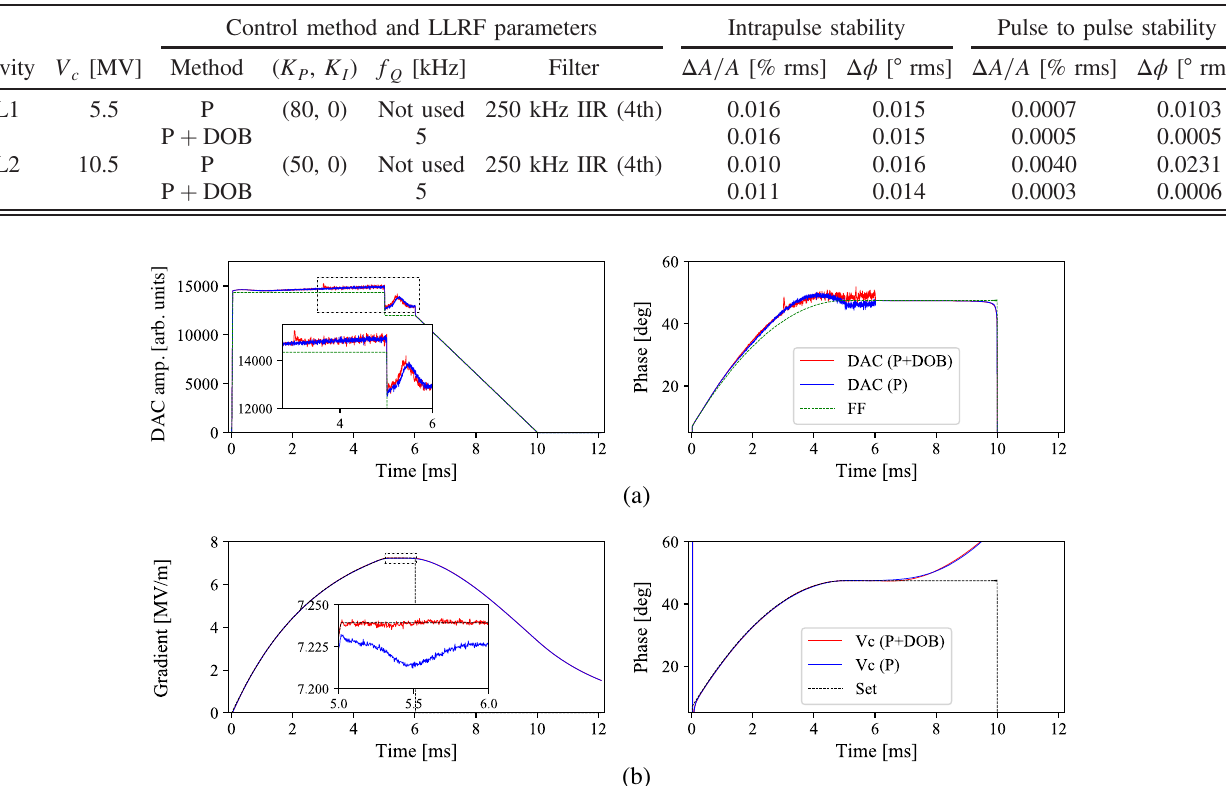
TABLE III. Performance of DOB control for rejecting the pulse-to-pulse fluctuations in the absence of the beam.